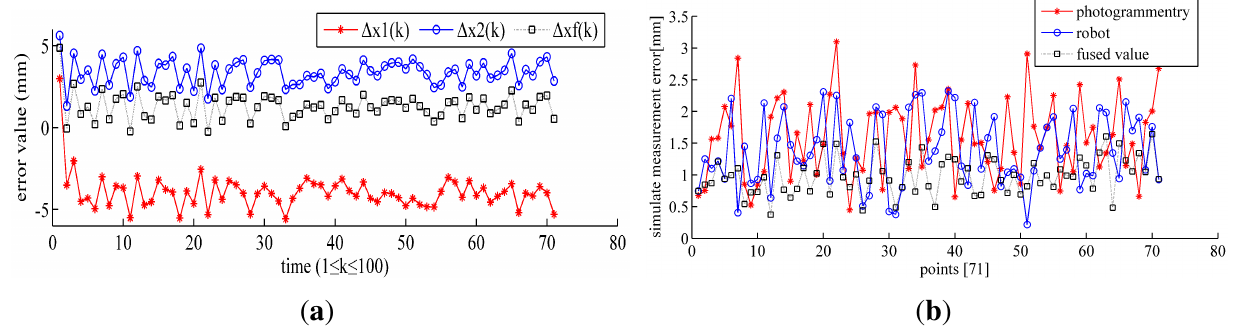
Figure 8. ( a ) The experimental error using KF; ( b ) the experimental error using MOIFA.